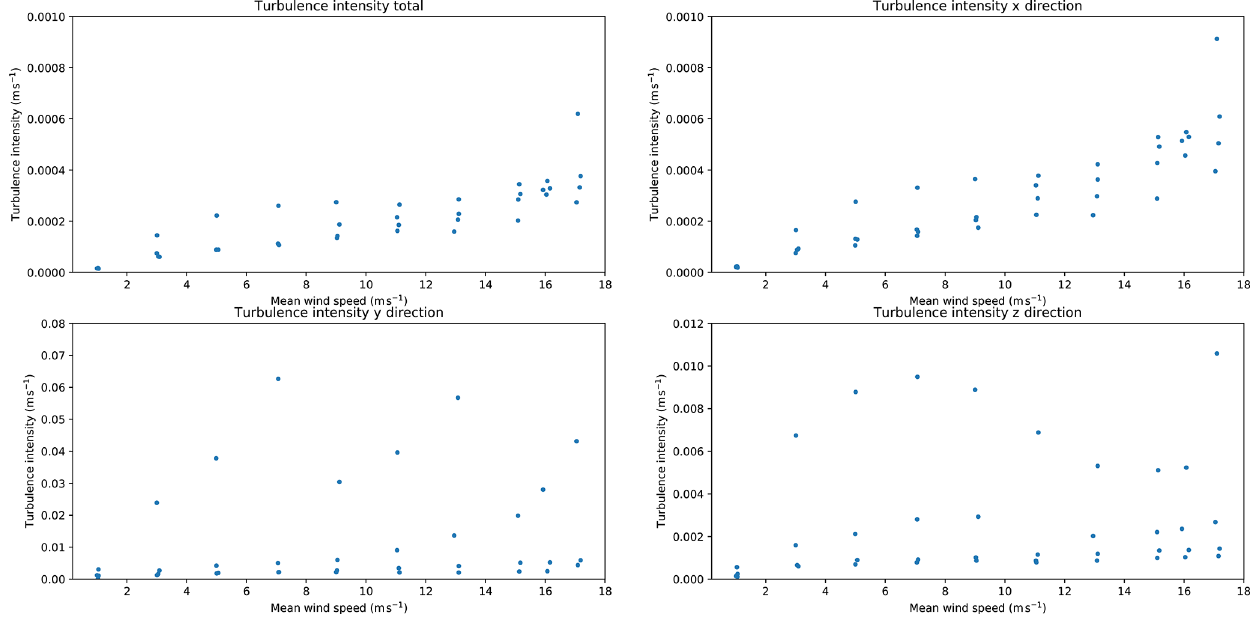
Figure C2. Turbulence intensity (variance divided by mean wind speed) (ms − 1 ) in the wind tunnel during the AHFO experiment. The x direction is in the flow direction. The y direction is the width direction. The z direction is the height direction.